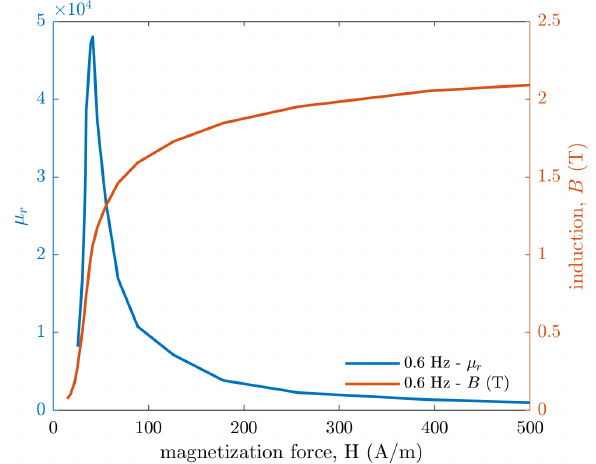
FIG. 4. Relative permeability and induction curves of the AFK502R sample from Aperam [9] measured at CERN with an Epstein frame.